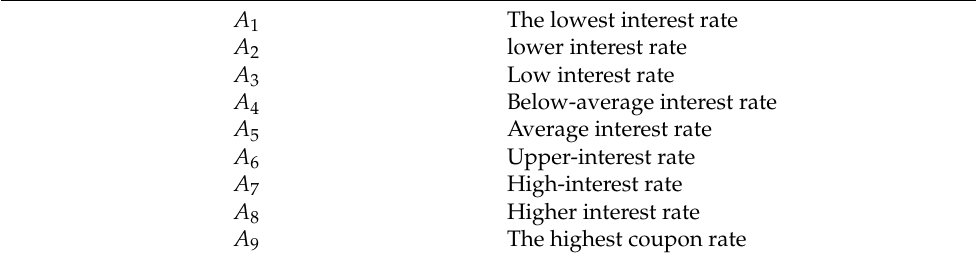
Table 19. Interest rate linguistic variable